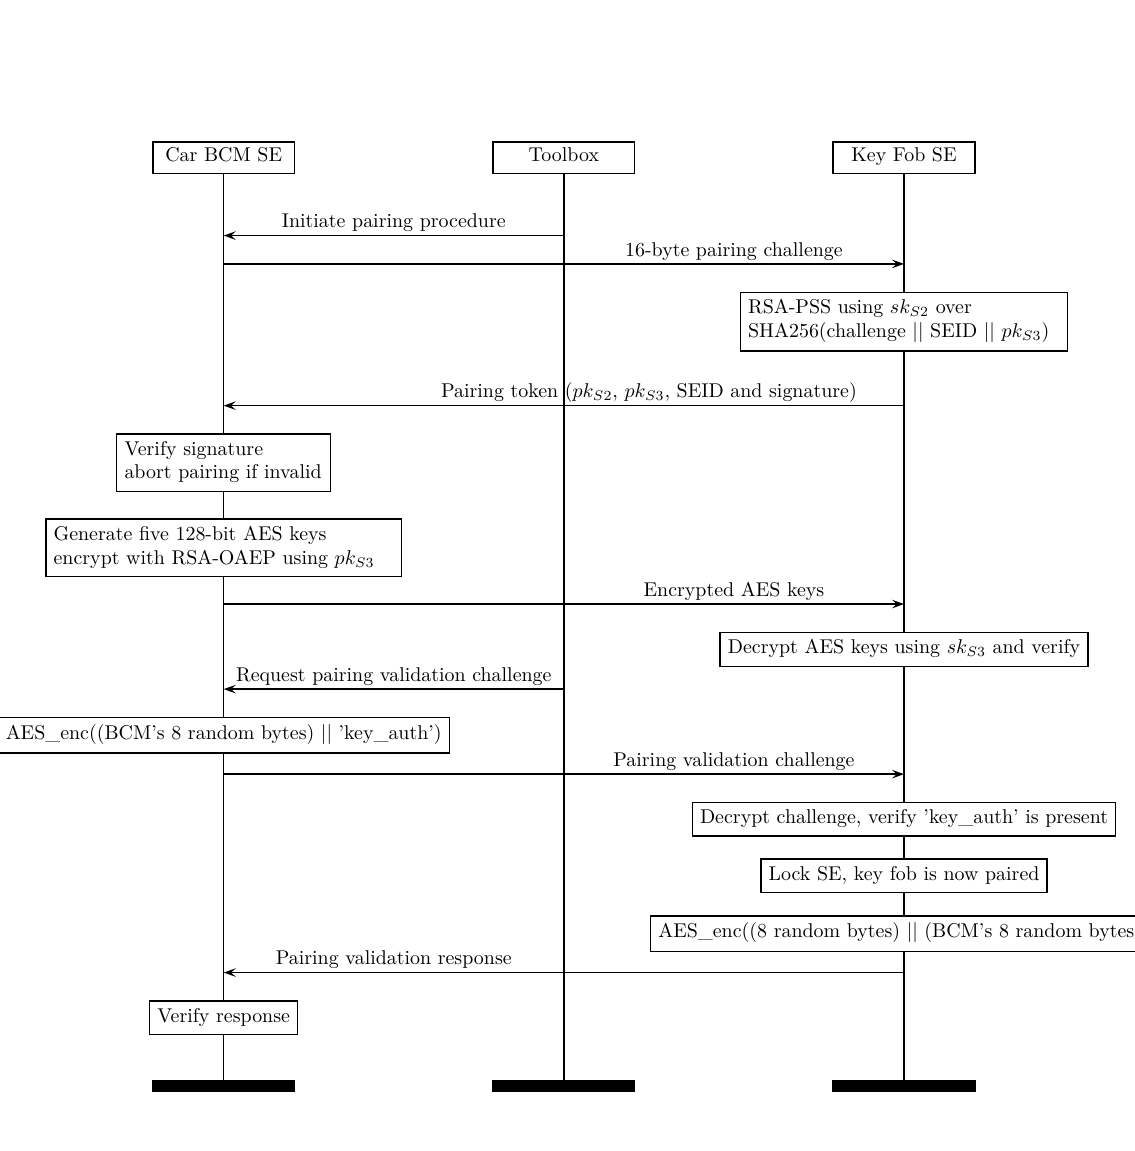
Figure 7: The pairing protocol as it is used during normal operation. We use || to denote the concatenation operation. pk Sx and sk Sy denote the RSA public key from slot x and the RSA private key from slot y